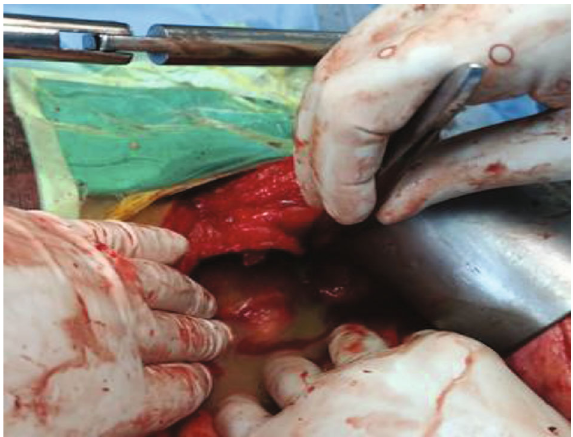
Figure 2: A localized collection of pus in the lesser sac of the abdomen.